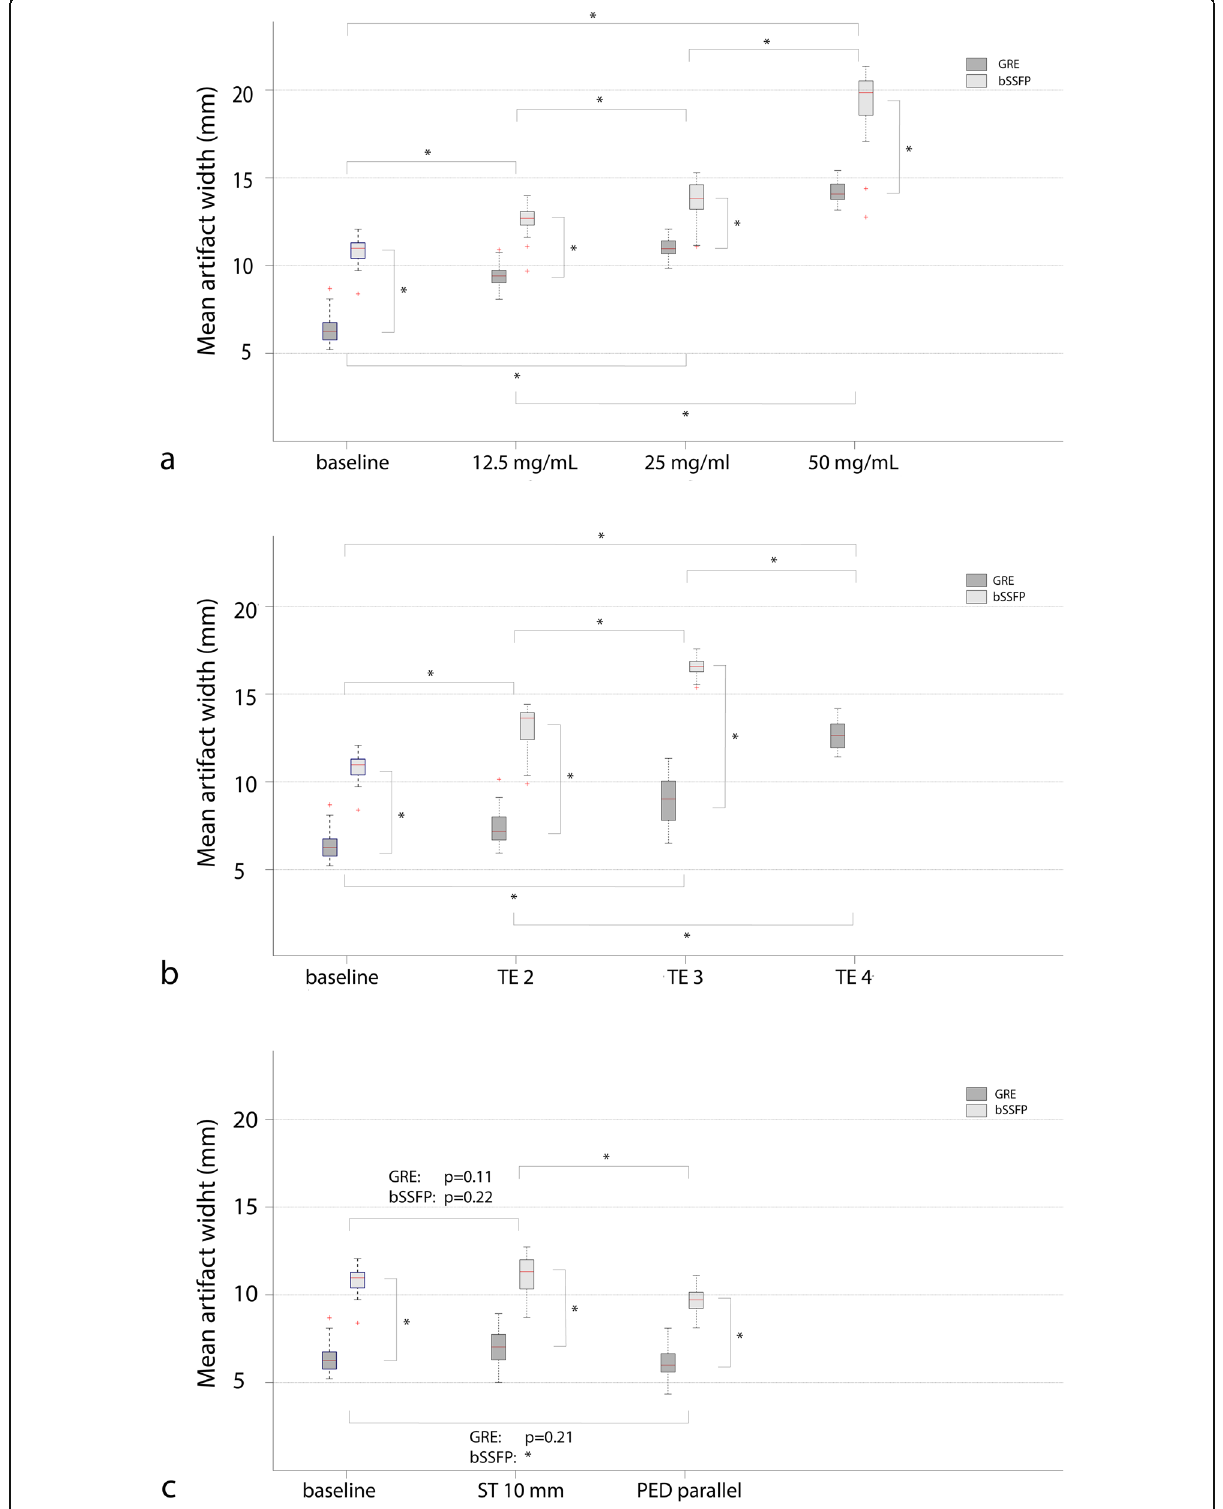
Fig. 5 Boxplots of mean artifact width for the different parameters: iron(II,III)oxide concentration ( a ); echo times (TE) ( b ); slice thickness (ST) and phase encoding direction (PED) ( c ). bSSFP Balanced steady-state free precession, GRE Gradient echo. * p <